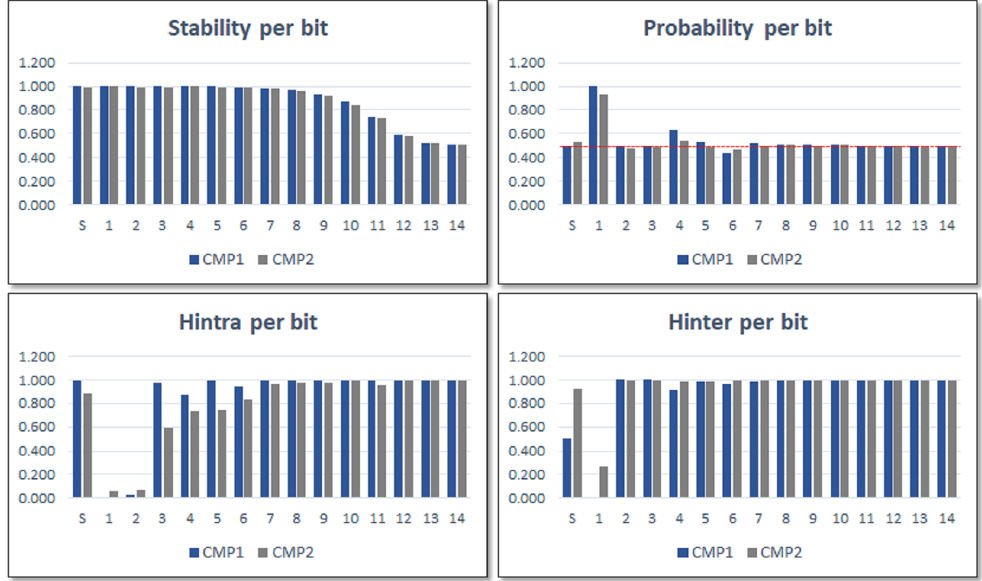
Figure 9. Stability, probability, and entropy metrics calculated for each bit of the counters (average values for 100 combinations of development board, PUF instance, and configuration options). The red line corresponds to the ideal proability